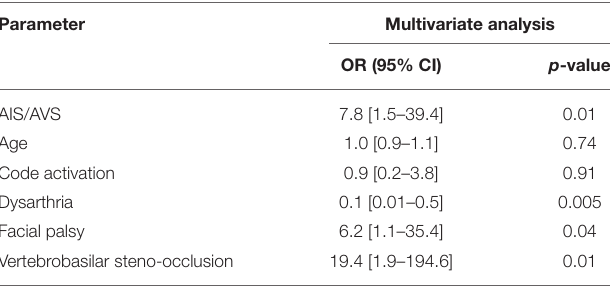
TABLE 4 | Clinical predictors of a good outcome in patients with minor posterior circulation